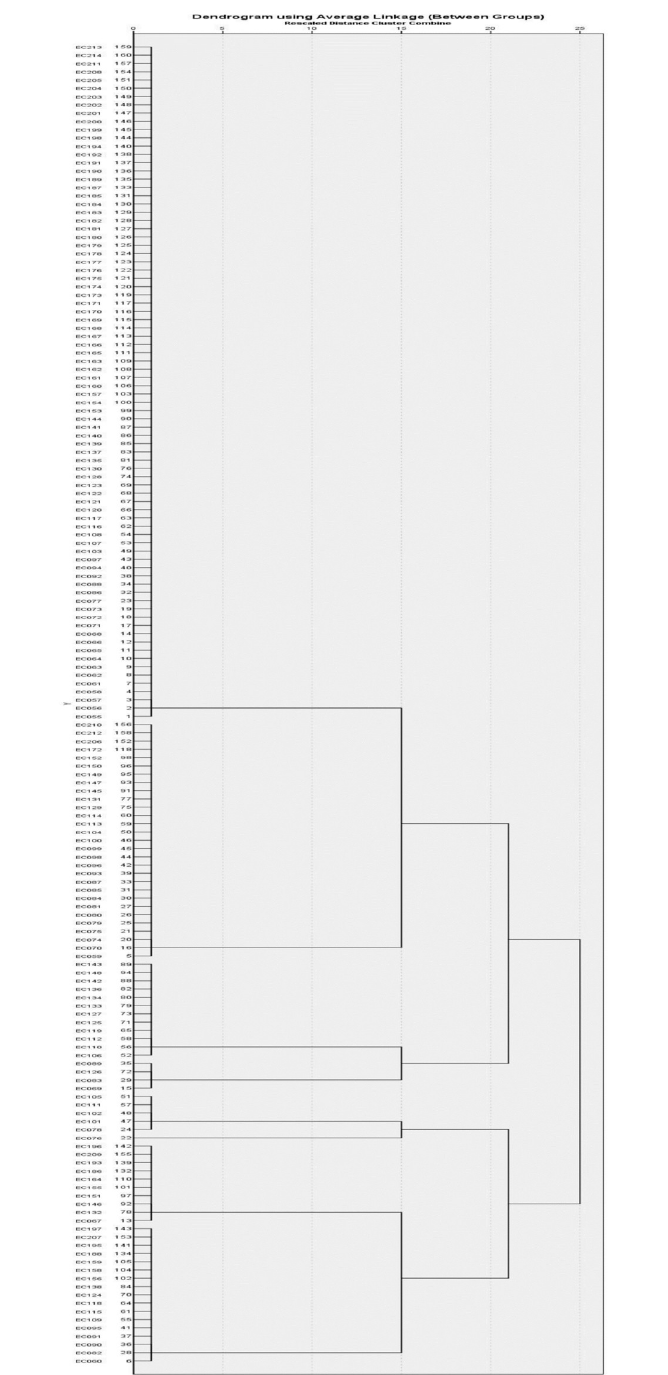
Fig 1. Hierarchical clustering of E . coli isolates according to the presence of adhesion functional virulence genes ( fimH , papC and sfa ).